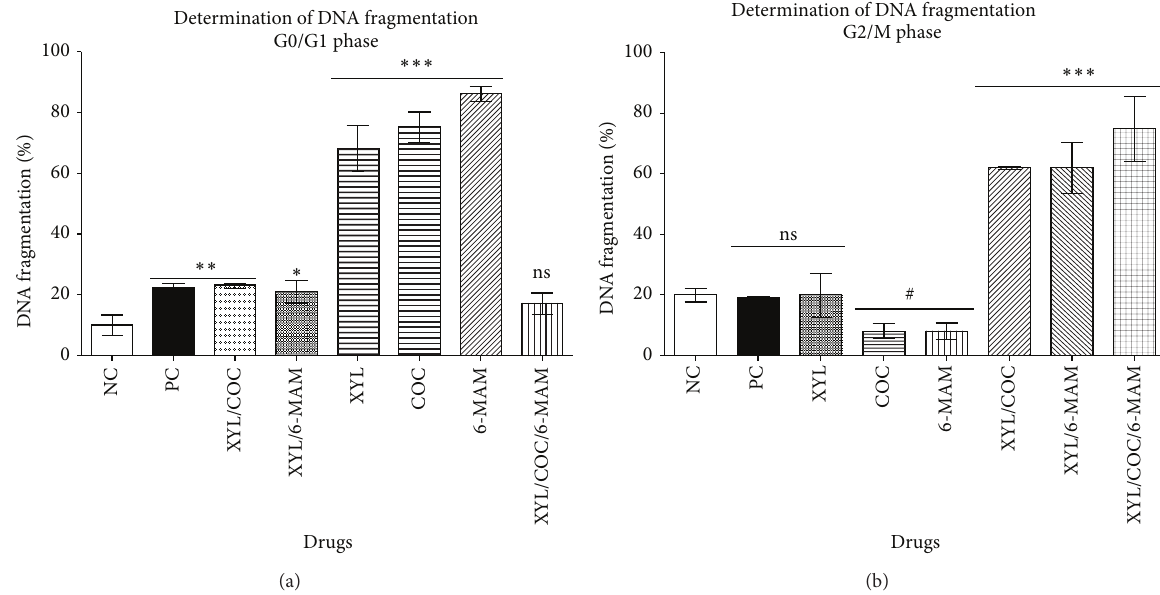
Figure 3: Effect of xylazine, cocaine, 6-monoacetylmorphine, and their combination on DNA fragmentation content in human umbilical vein endothelial cells (EA.hy926). DNA fragmentation content in EA.hy926 cells after 24 h of exposure to vehicle (negative control group, NC), camptothecin (positive control group, PC, 50 𝜇 M), xylazine (XYL, 60 𝜇 M), cocaine (COC, 160 𝜇 M), 6-monoacetylmorphine (6-MAM, 160 𝜇 M), XYL/COC (50 𝜇 M), XYL/6-MAM (50 𝜇 M), and XYL/COC/6-MAM (40 𝜇 M) was evaluated in each phase independently and compared to negative control group. DNA fragmentation content assay was performed to measure cells containing less than 1DNA equivalent (Sub-G1) after degradation of DNA triggered by endonucleases or drug interaction [35]. Cells were harvested after drug treatment, fixed with 70% ethanol, incubated 24 hours at 4 ∘ C, stained with 1 𝜇 g/ml DAPI (5 min incubation), and image-analyzed with NucleoCounter NC-3000 instrument. Results obtained in phase G0/G1 (a) show significant difference ( 𝑃 < 0.0001 ) in cells exposed to XYL, COC, and 6-MAM. Cells treated with XYL in combination with COC or 6-MAM presented significant difference ( 𝑃 < 0.001, 0.01 , respectively), but lower than previously described. Phase G2/M (b) presented no significant difference ( 𝑃 > 0.05 , ns) in cells treated with XYL. Cells treated with these three-drug combination presented significant difference ( 𝑃 < 0.0001 ) when compared with the negative control group. The experiment was repeated for at least three times. All values areexpressed as mean ± SD of 6–9 replicates, from2 to 3 experiments. Statistical analysis performed was one-way ANOVA, with Tukey post hoc test, where 𝑃 < 0.05 was considered significant. 𝑃 summary; ∗∗∗ 𝑃 < 0.0001 significantly different when compared to negative control group, ∗∗ 𝑃 < 0.001 , ∗ 𝑃 < 0.01 , ns = no significant difference from negative control group ( 𝑃 > 0.05 ). Results percent (%) was calculated by negative control